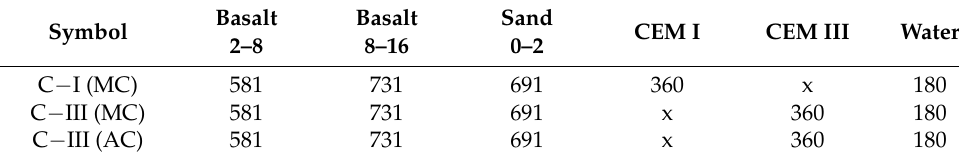
Table 2. Composition of concrete mixtures [kg/m 3 ].